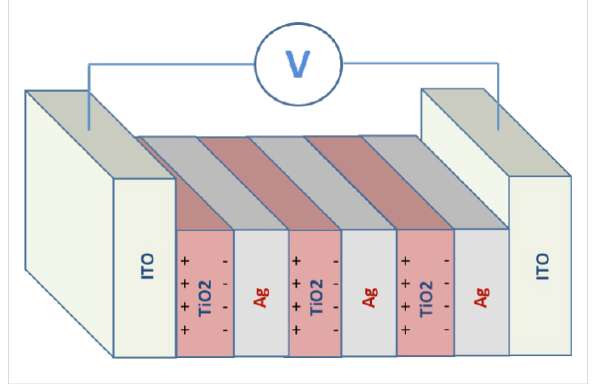
Figure 5: Scheme of the interpretation of the action of the electric field on the ITO–(Ag nanoparticle/TiO 2 nanoparticle) 5 –Ag–ITO photonic crystal